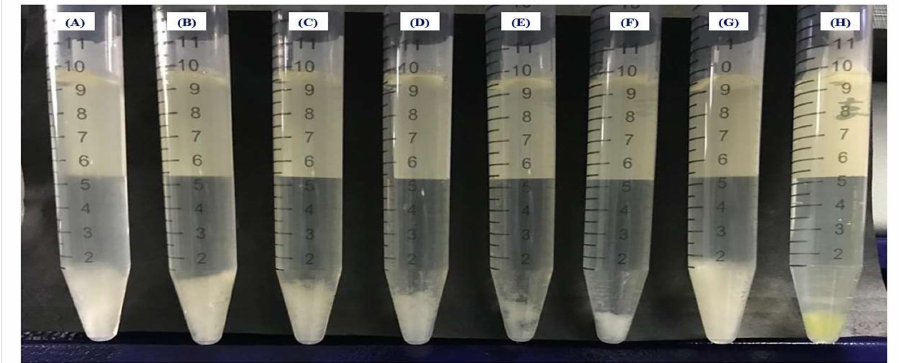
Figure 3. The turbidity of C. albicans in SDB at 35 ◦ C after 24 h treatment with ( A ) 5 µ g/mL, ( B ) 10 µ g/mL, ( C ) 20 µ g/mL, ( D ) 40 µ g/mL, ( E ) 80 µ g/mL, and ( F ) 160 µ g/mL of ZnO NPs, and a negative control ( G ), and a positive control ( H